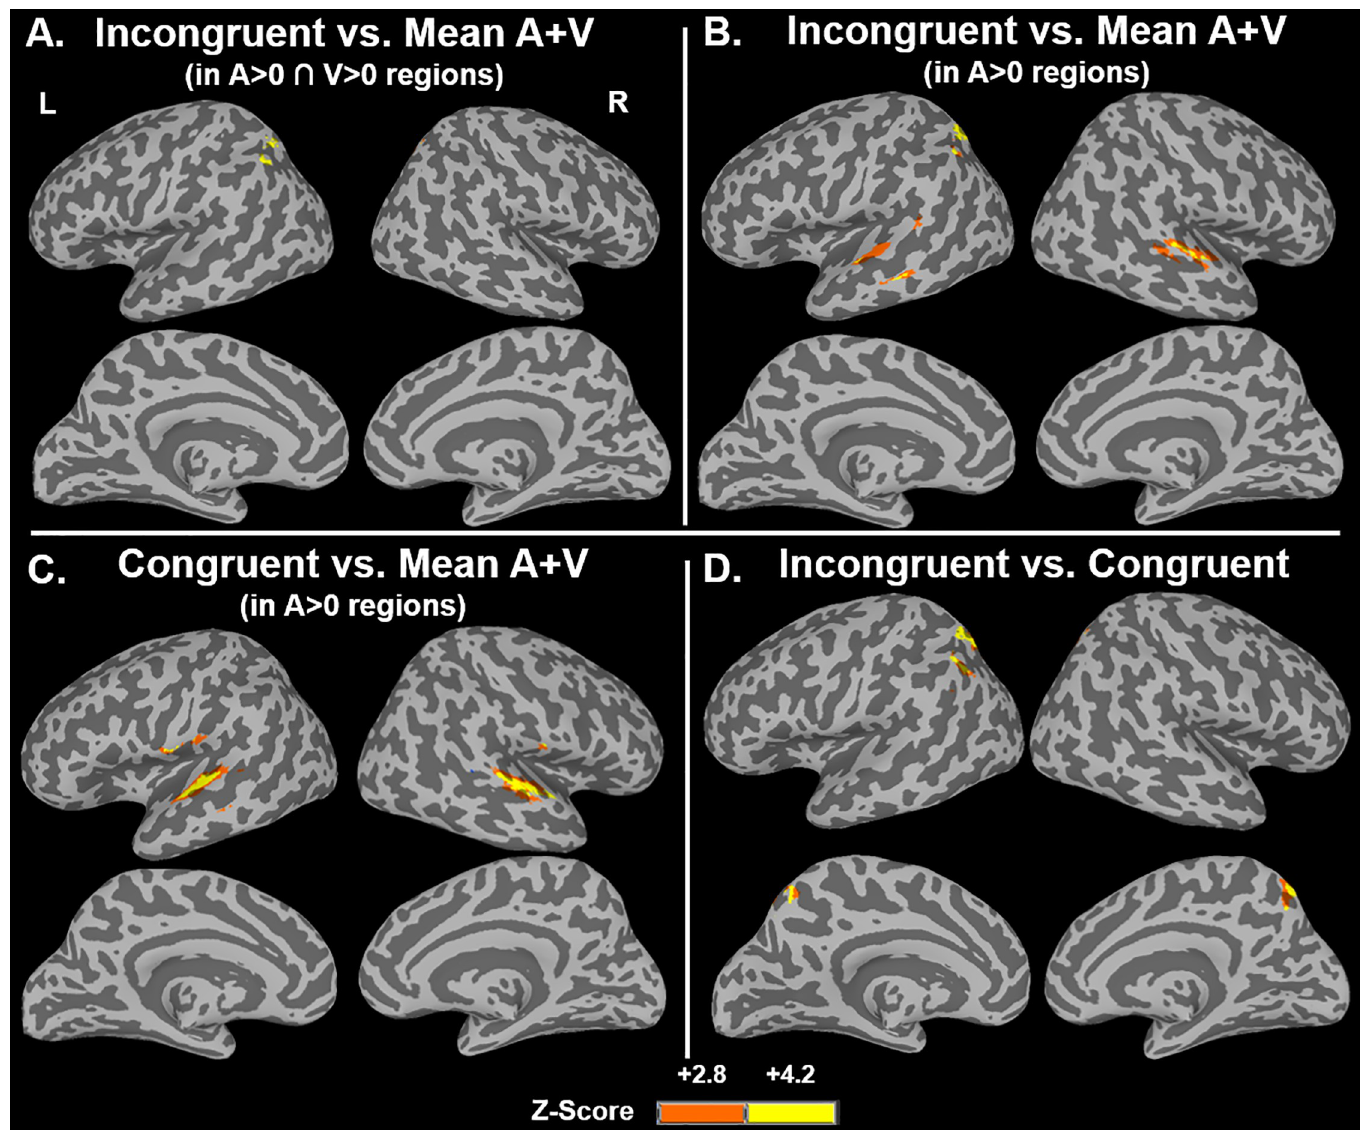
Fig 4. Activation for AV interference, facilitation, and conflict resolution. (A) Voxels whose activation is greater for AV incongruent trials than the mean of audio- and visual-only trials in A > 0 \ V > 0 regions. (B) Voxels whose activation is greater for AV incongruent trials than the mean of audio- and visual-only trials in A > 0 regions. (C) Voxels whose activation is greater for AV congruent trials than the mean of audio- and visual-only trials in A > 0 regions. (D) Voxels whose activation is greater for AV incongruent trials than AV congruent